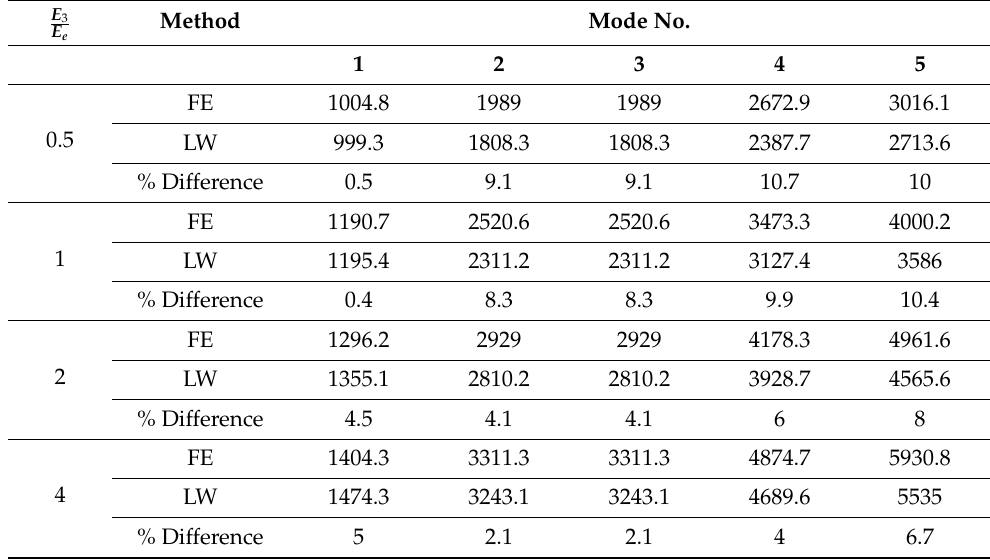
Table 14. The effect of any deviation in core elastic modulus from that of Elastollan ® R 3000. n = 1 , h